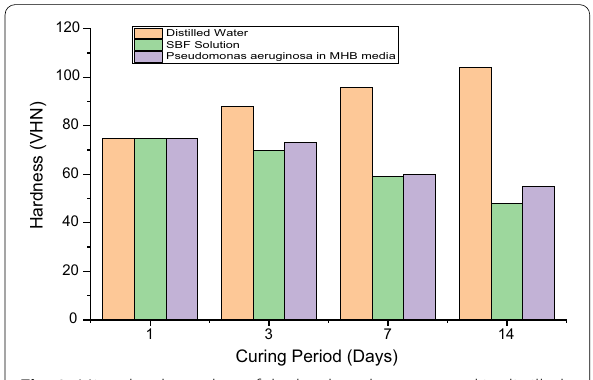
Fig. 3 Micro-hardness data of the hardened pastes cured in distilled water (DW), simulated body fluid (SBF) and Pseudomonas aeruginosa in Mueller Hinton Broth (MHB